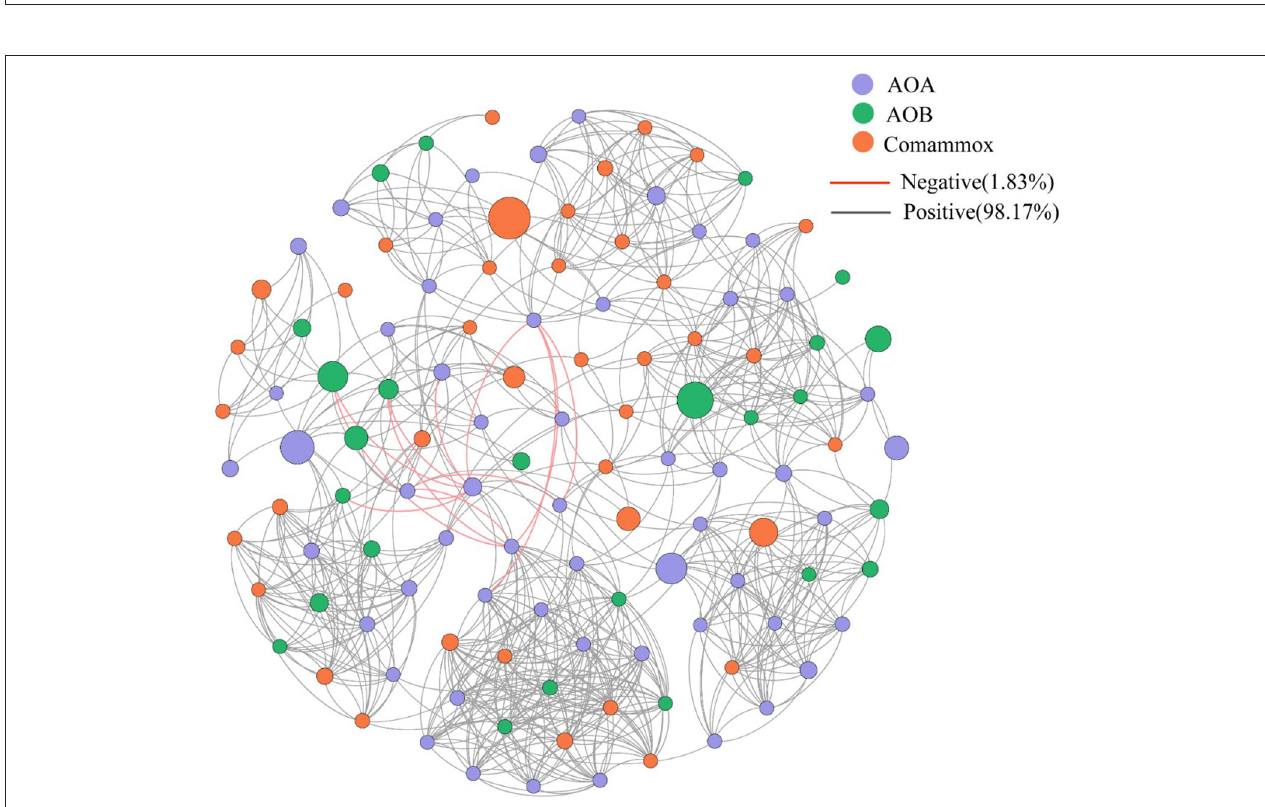
FIGURE 5 | Network analysis of all ammonia oxidizers. Different colored circles represent different ammonia oxidants, orange lines represent negative interaction, black lines represent positive interaction.